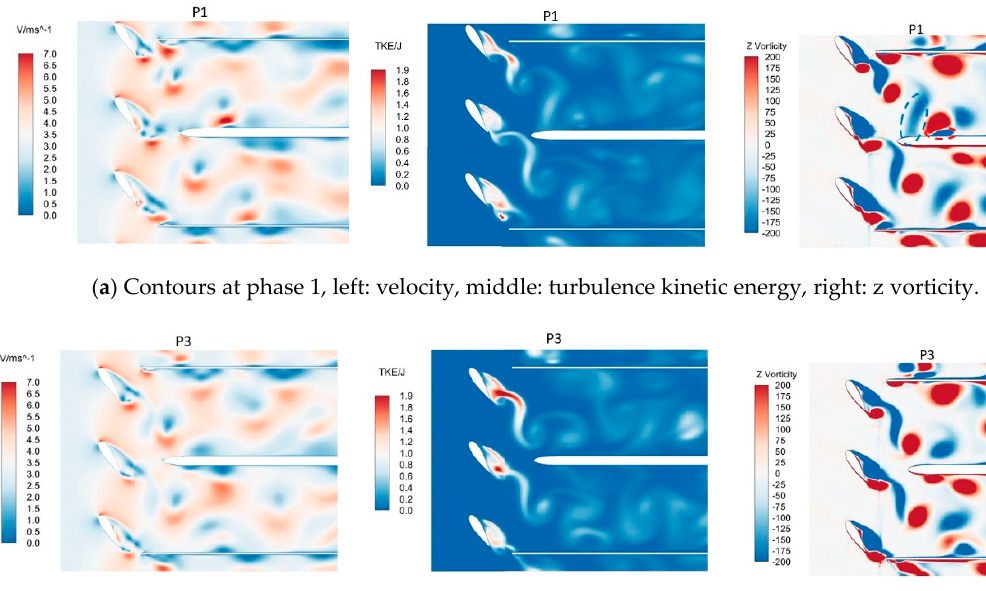
( b ) Contours at phase 2, left: velocity, middle: turbulence kinetic energy, right: z vorticity. Figure 12.